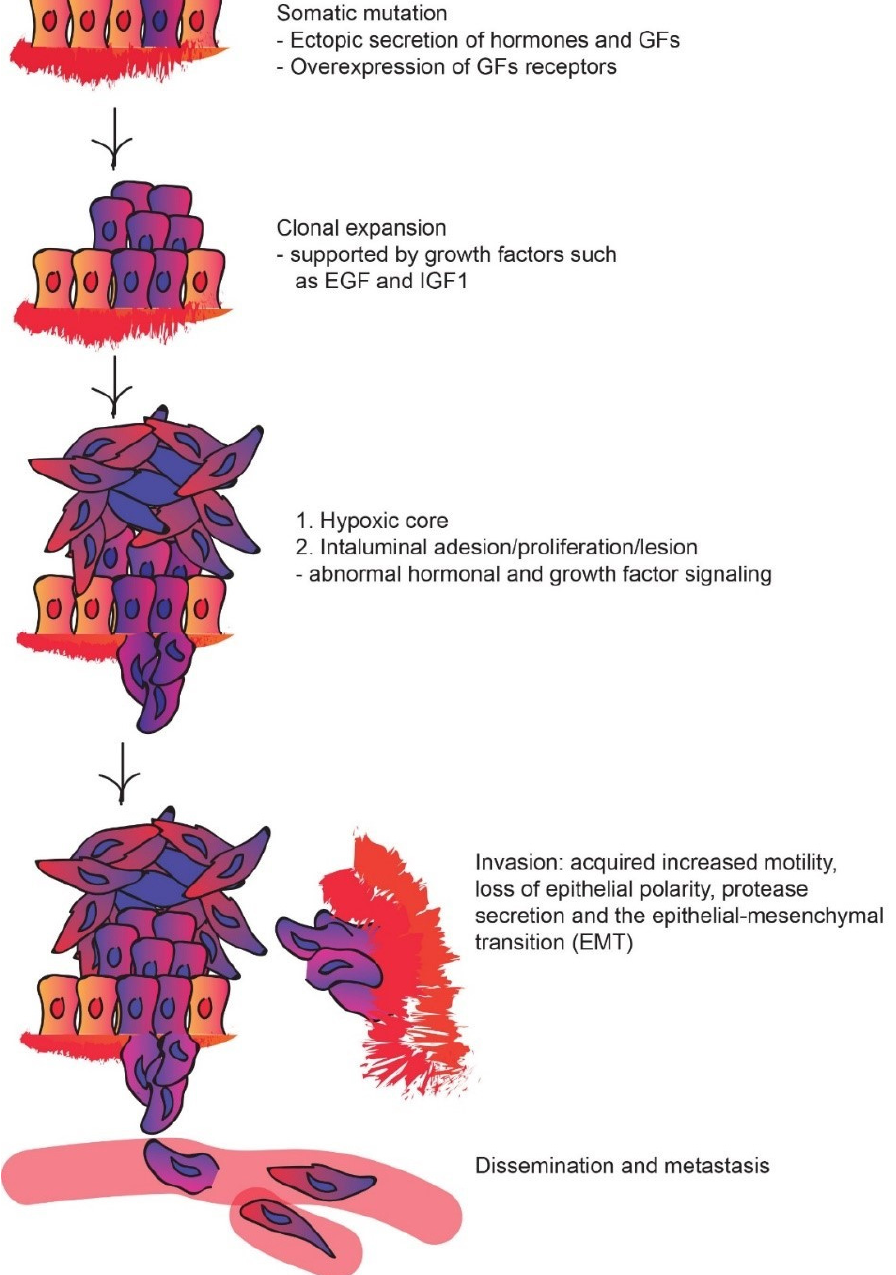
Figure 1. Schematic of tumor growth and progression (affected by hormone and GF signaling): somatic mutation, clonal expansion, intraluminal cell proliferation and intraluminal lesion formation, invasion, dissemination, the formation of micrometastases, resistant tumor clones, angiogenesis, and ultimately metastases.